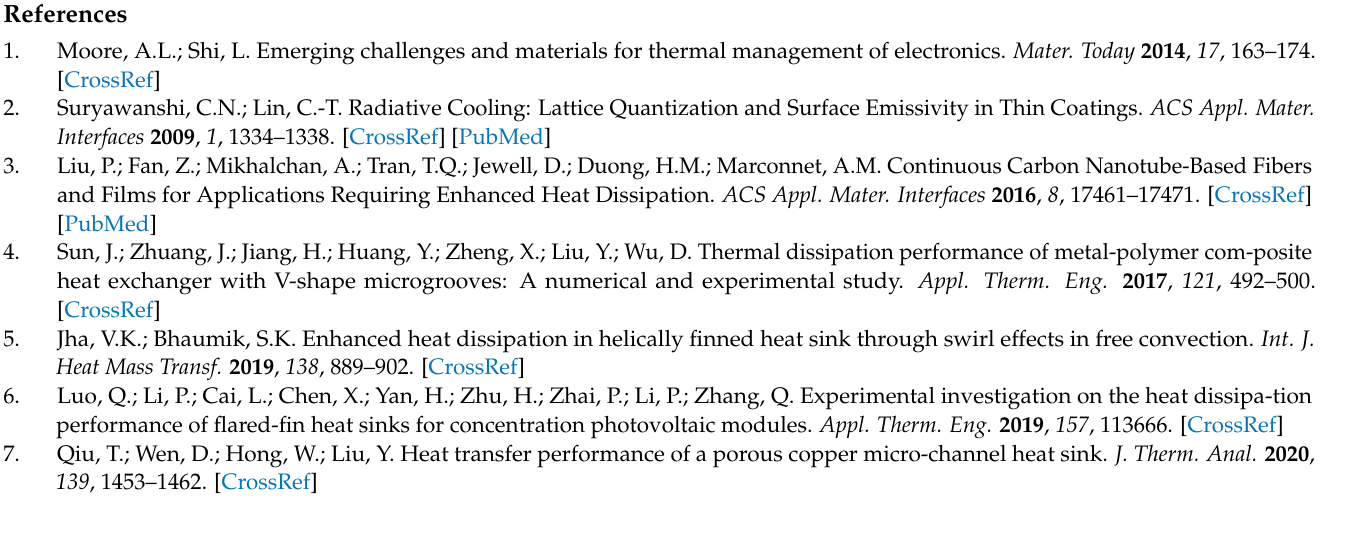
exfoliating graphene flakes. Figure S2: Graphene aqueous suspensions prepared using various surfactants. (a) Initial. (b) 1 hr. (c) 12 hr. (d) 3 days. Figure S3: CNT aqueous suspensions prepared using various surfactants. (a) Initial. (b) 3 min. (c) 10 min. (d) 3 days. Table S1: Linear regression analysis of heating